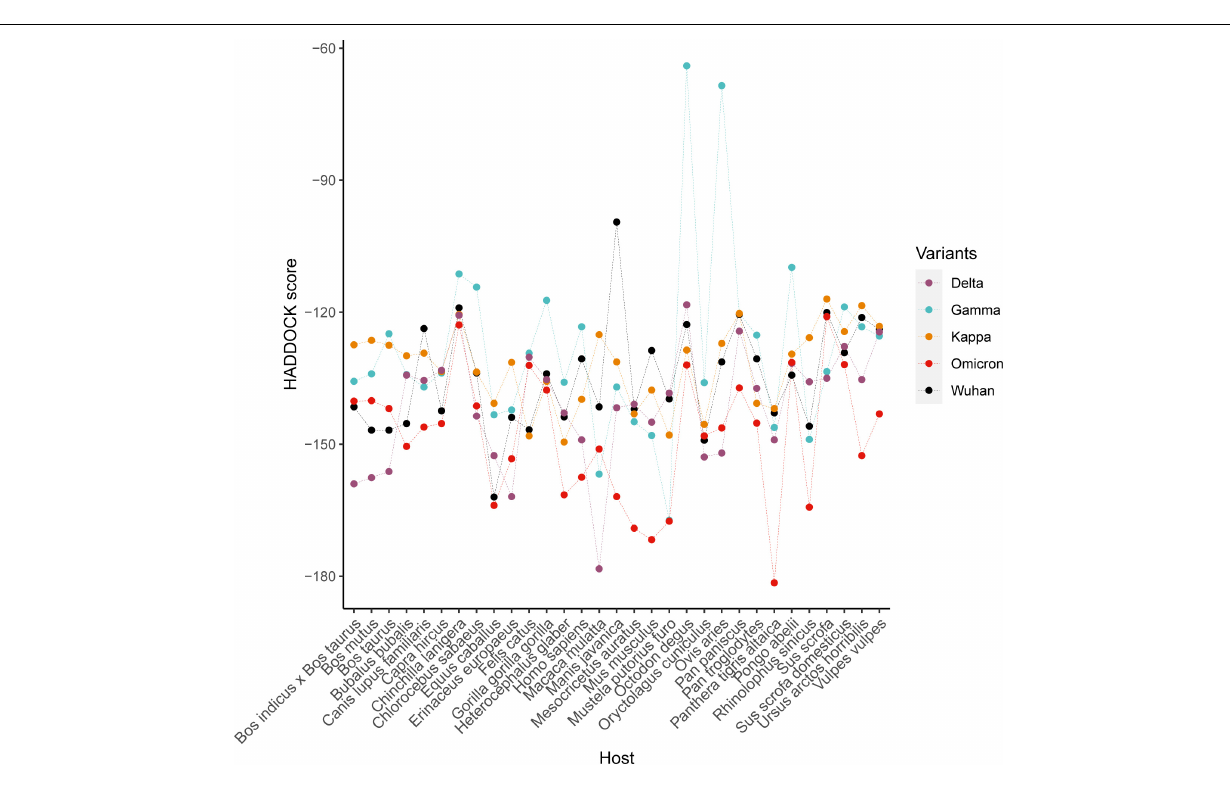
FIGURE 5 | The HADDOCK scores of complexes formed by the ACE2 proteins of 31 species and the viral spike proteins from five SARS-CoV-2